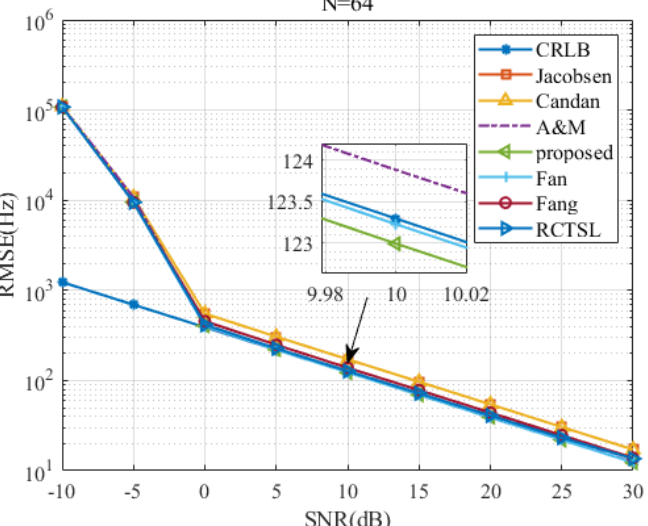
Figure 7. RMSE comparison among frequency estimates versus SNR at N = 64 and δ = 0.2.